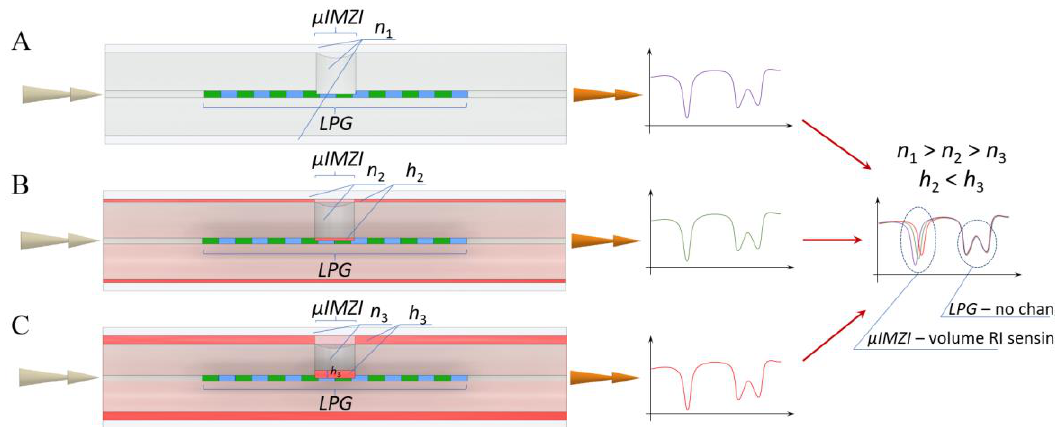
Figure 8. A schematic showing LPG- µ IMZI influenced by ( A ) high external RI, ( B ) thin film and lower external RI, and ( C ) thick film and the lowest external RI. For this specific combination of external RIs (n 1 , n 2 , and n 3 ) and film thicknesses, only the response of µ IMZI would allow discriminating the cases.